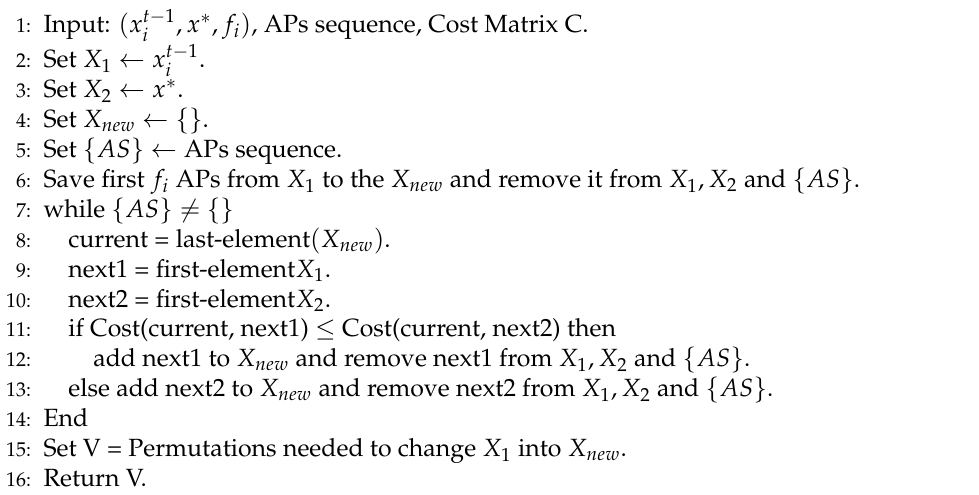
Algorithm 2 Two-exchange crossover algorithm.